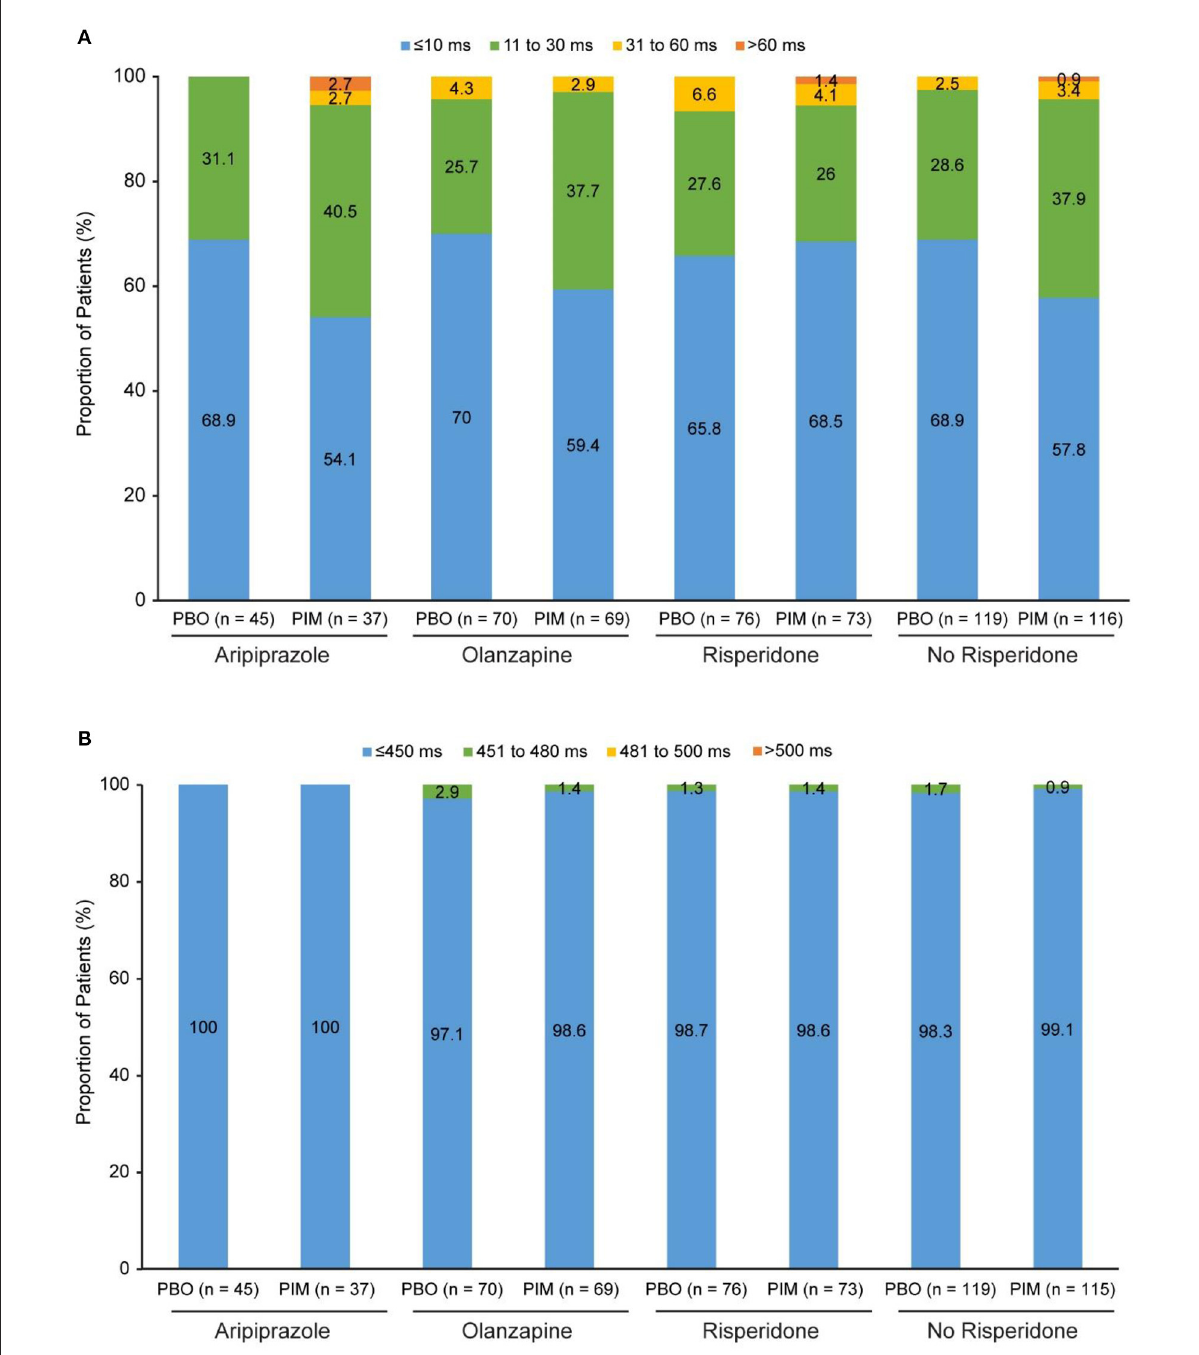
FIGURE1 ENHANCE: (A) Change in QTcF from baseline to overall postbaseline maximum and (B) QTcF overall postbaseline maximum. PBO, placebo; PIM, pimavanserin; QTcF, QT interval using Fridericia’s correction method.